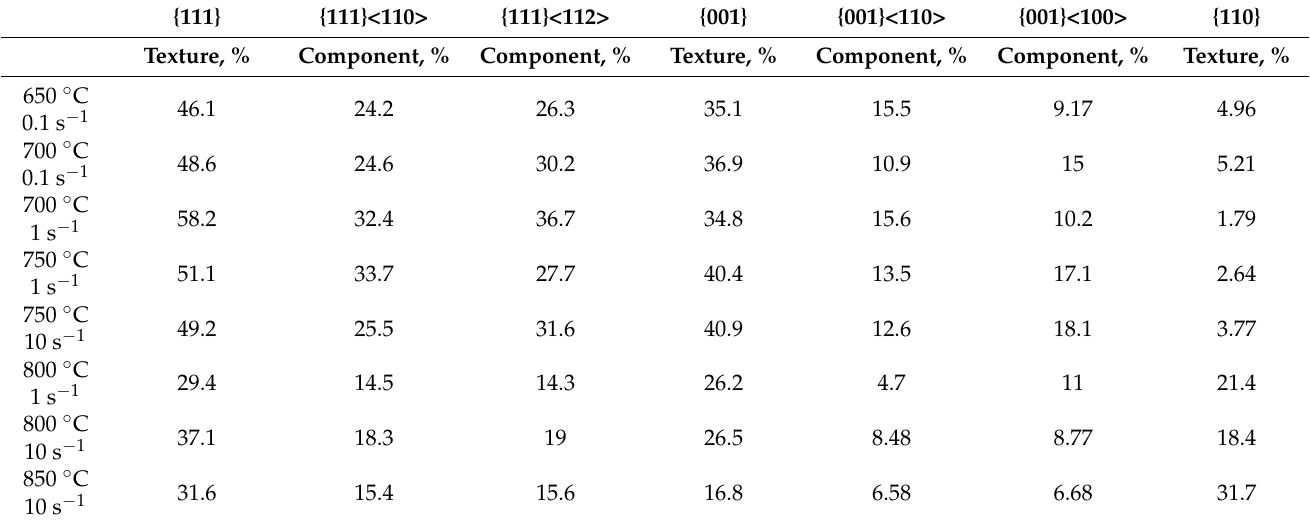
Table 1. The percentage of the texture component (divergence angle = 20 ◦